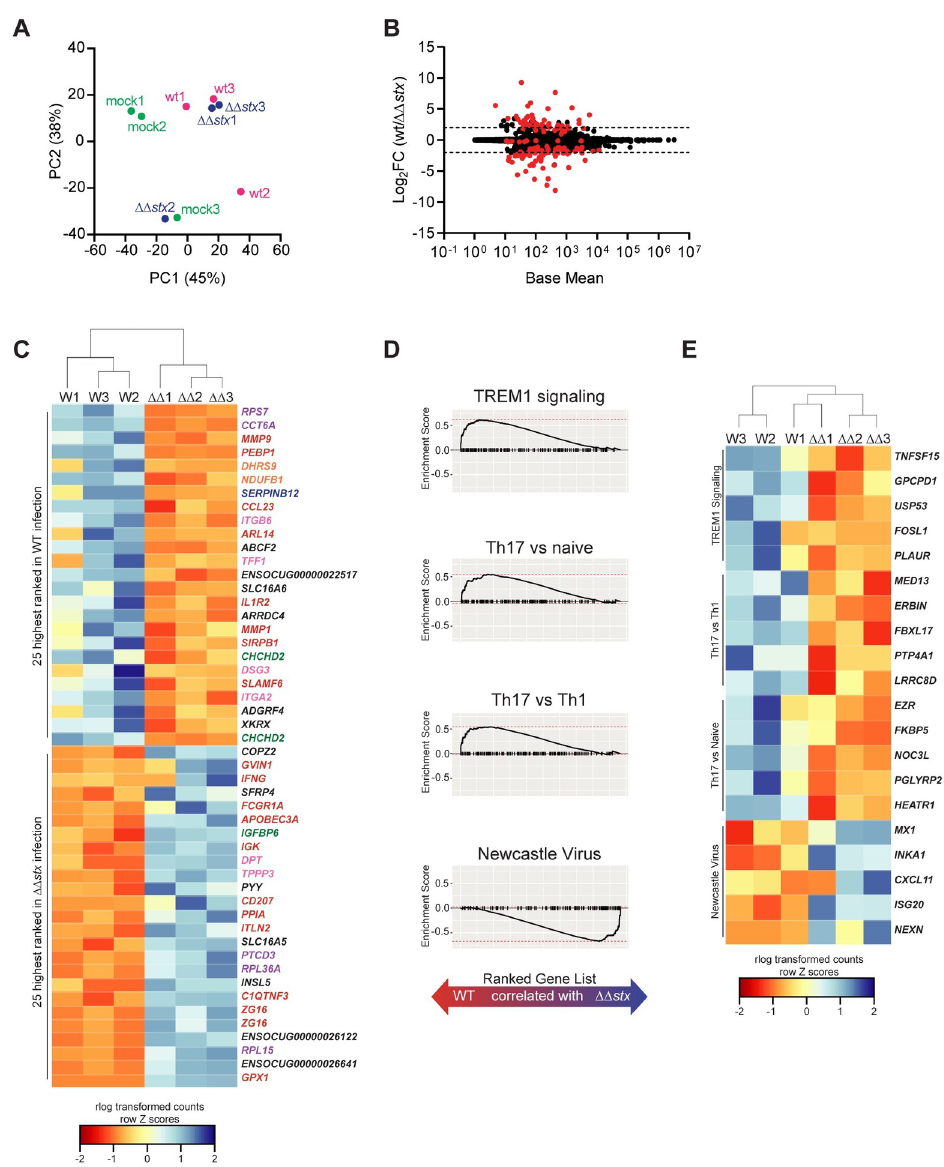
Fig 3. Profiles of colonic lamina propria cell transcriptional responses differ between animals infected with WT and ΔΔ stx EHEC. (A) Principal component analysis of rlog-transformed expression values of lamina propria cells. (B) Average expression level (base mean) and log2 fold change of transcript abundance from rabbits inoculated with WT or ΔΔ stx EHEC. Red dots are genes with significantly different (p < 0.05) transcript abundance. Dashed line indicates log2 fold change > 2 or < -2. (C) Heat map of rlog-transformed read counts for top 25 and bottom 25 genes by rank. Rows are Z-normalized. Gene names are colored by function: red–immune, orange–metabolism, green–proliferation/ apoptosis, blue–coagulation, purple–translation/protein folding, pink–barrier function/cytoskeleton, black– uncharacterized or other. (D) Gene set enrichment plot for selected pathways. Black tick marks are genes within pathway organized by rank. (E) Heat map of rlog-transformed read counts for top 5 genes in the leading edge for indicated pathway organized by rank. 1126 had significantly different expression in WT/mock; for ΔΔ stx /mock, 497 genes were dif- ferentially expressed (S5 Fig and S1 and S2 Tables). 321 genes were similarly differentially expressed in both infection types (S6A Fig). Most of these shared genes were associated with